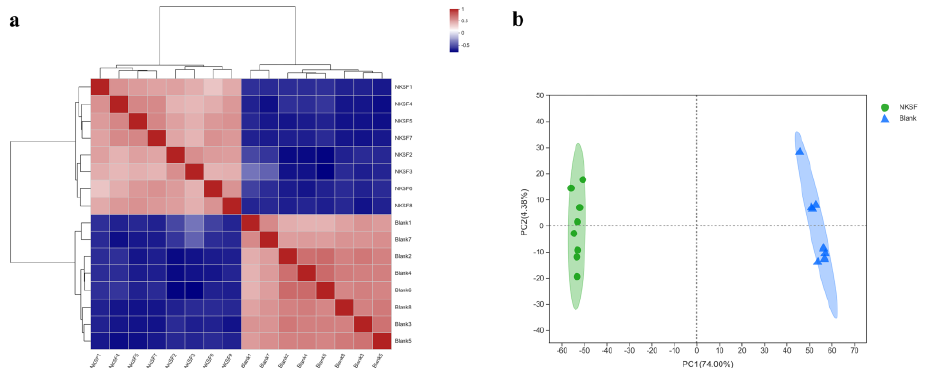
Figure 2. Metabolomics sample correlation analysis. ( a ) Sample correlation Heatmap; ( b ) sample PCA analysis.